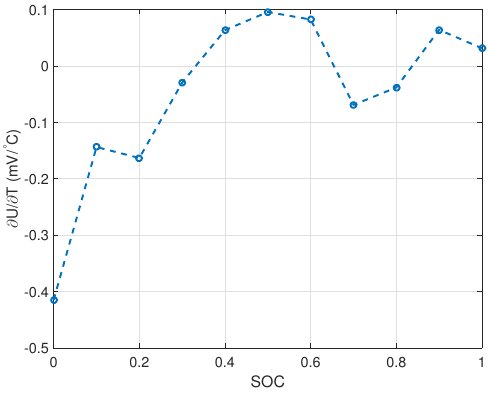
Figure 7. ∂ U / ∂ T estimation results.